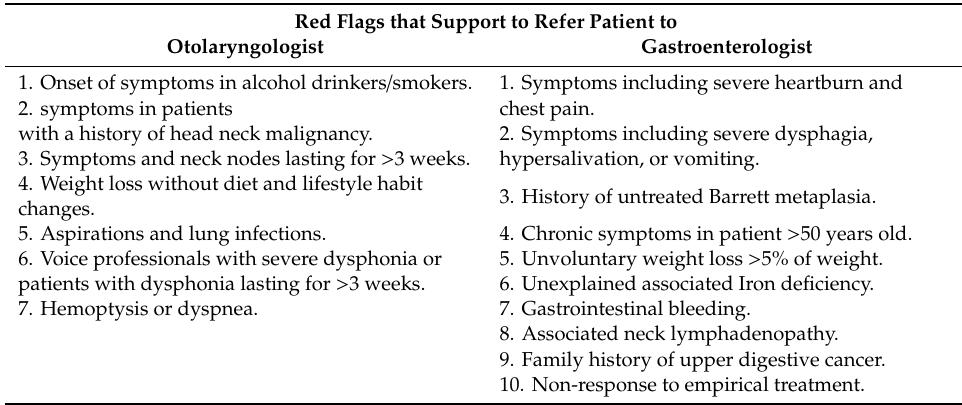
Table 2. Red flags requiring Specialist